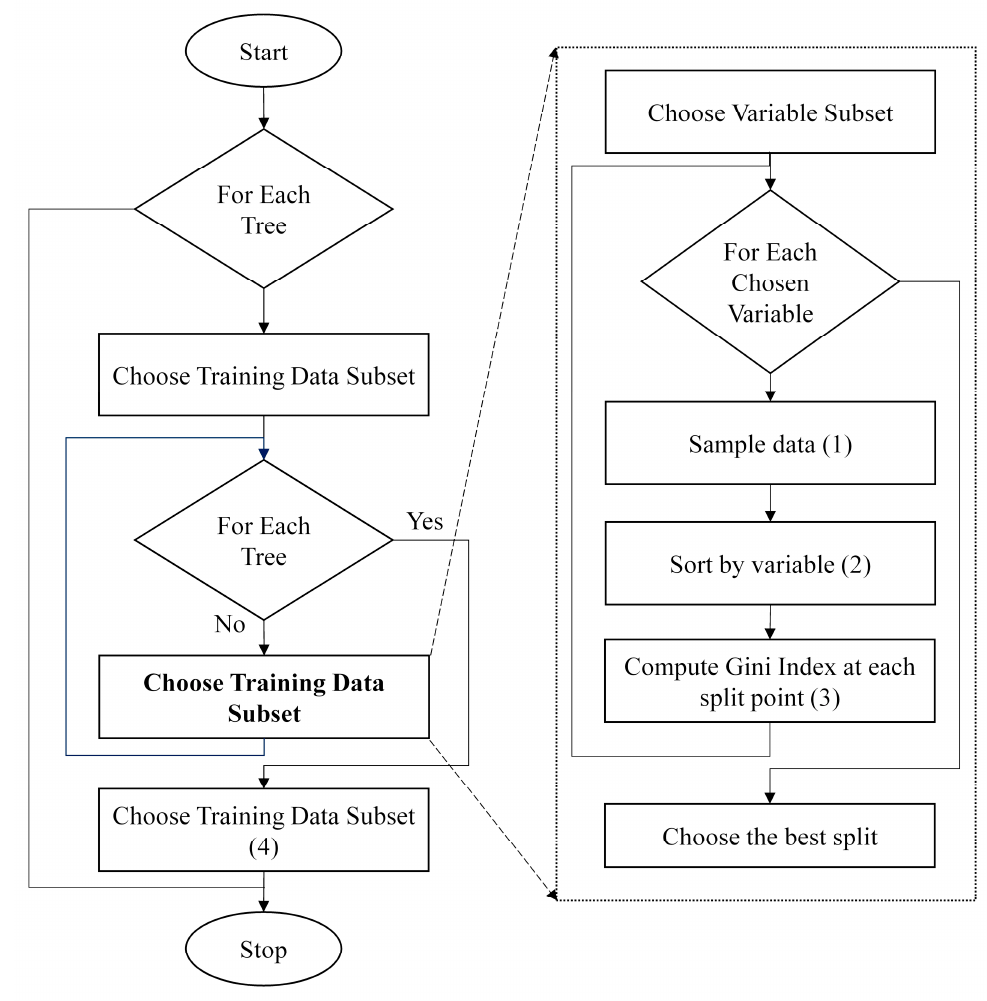
Figure 12. Algorithm flowchart of the RF model used in the present study to model the landslide chances. Choosing training data is the most extensive and rigorous process in this model.